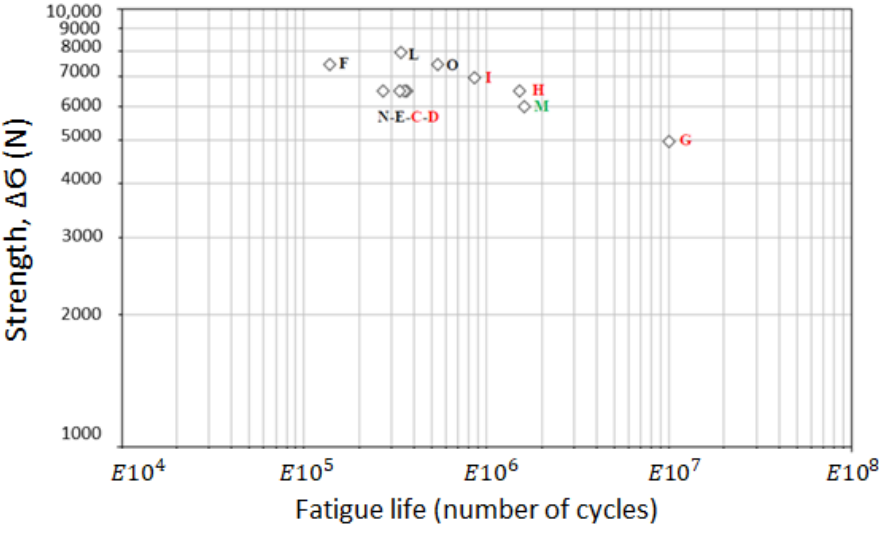
Figure 14. Number of cycles at break for sample